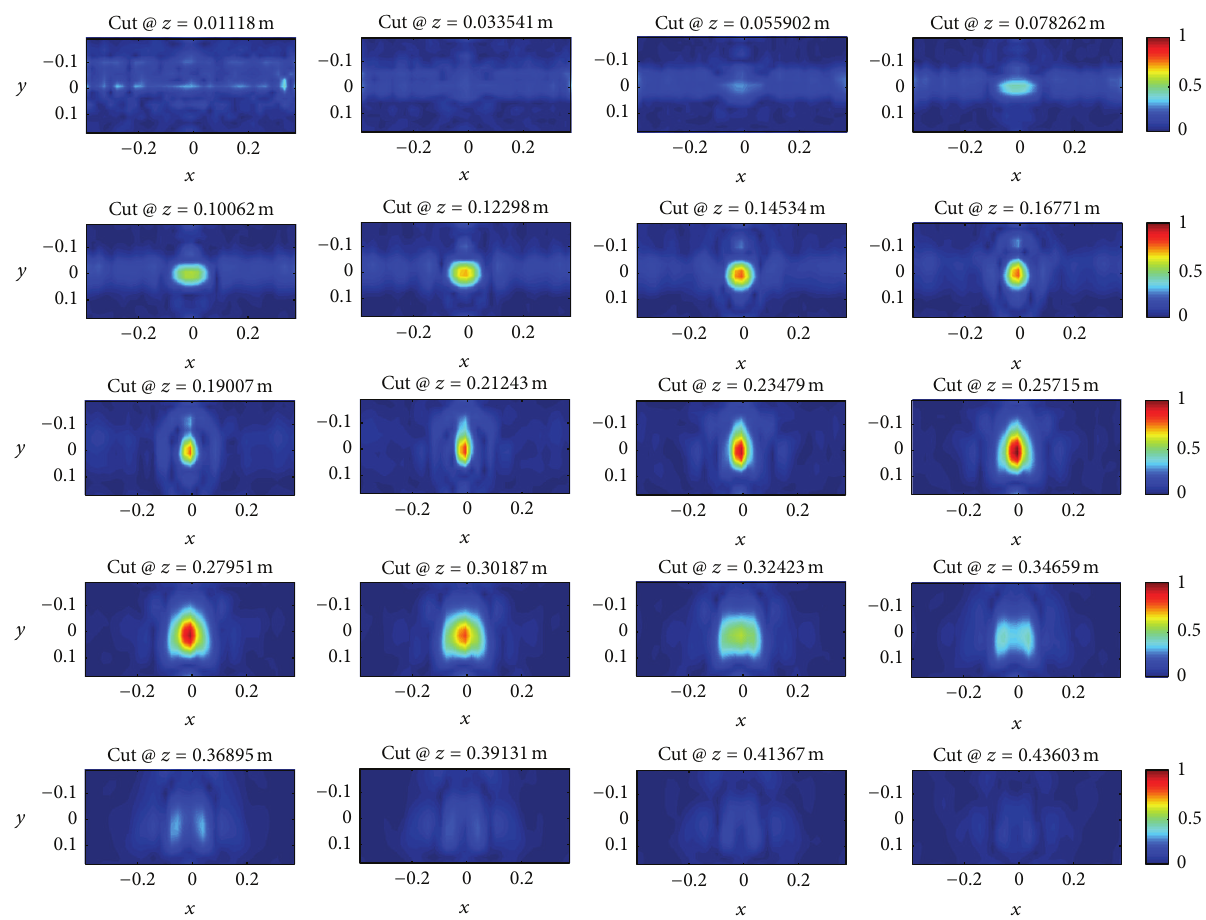
Figure 7: Depth slices of the contrast function reconstructed by processing the data set referred to a buried basalt sphere as in Figure